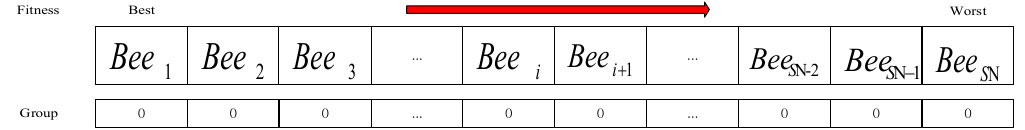
Figure 7. Schematic diagram of individual bee coding.